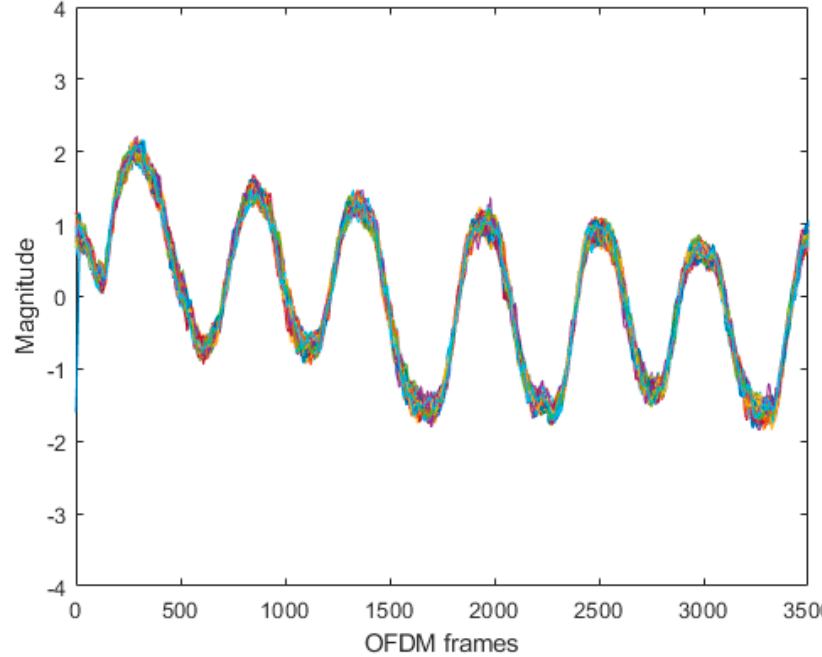
Figure 12. Magnitude response of slow breathing experiment.